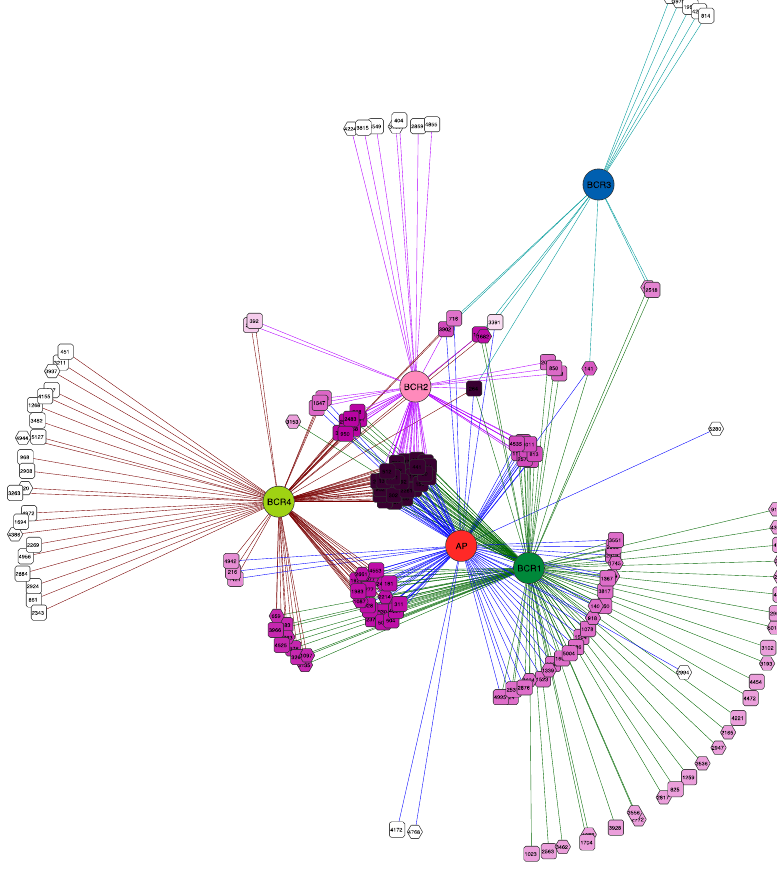
Figure 4. Bipartite network showing SRM operational taxonomic units (OTUs) (square nodes) found in the different BCRs and the algae pond (circular nodes). OTU nodes are connected via lines (edges) to sample nodes in which their sequences were found. Samples cluster together according to their shared OTUs, weighted according to the number of sequences within an OTU. The OTU-nodes are colored according to degree (number of samples that they were in). The darker purple OTU nodes were found in more samples than the OTU nodes with lighter purple color that were restricted to fewer samples. Sample colours are the same as those used in Figures 1–3.